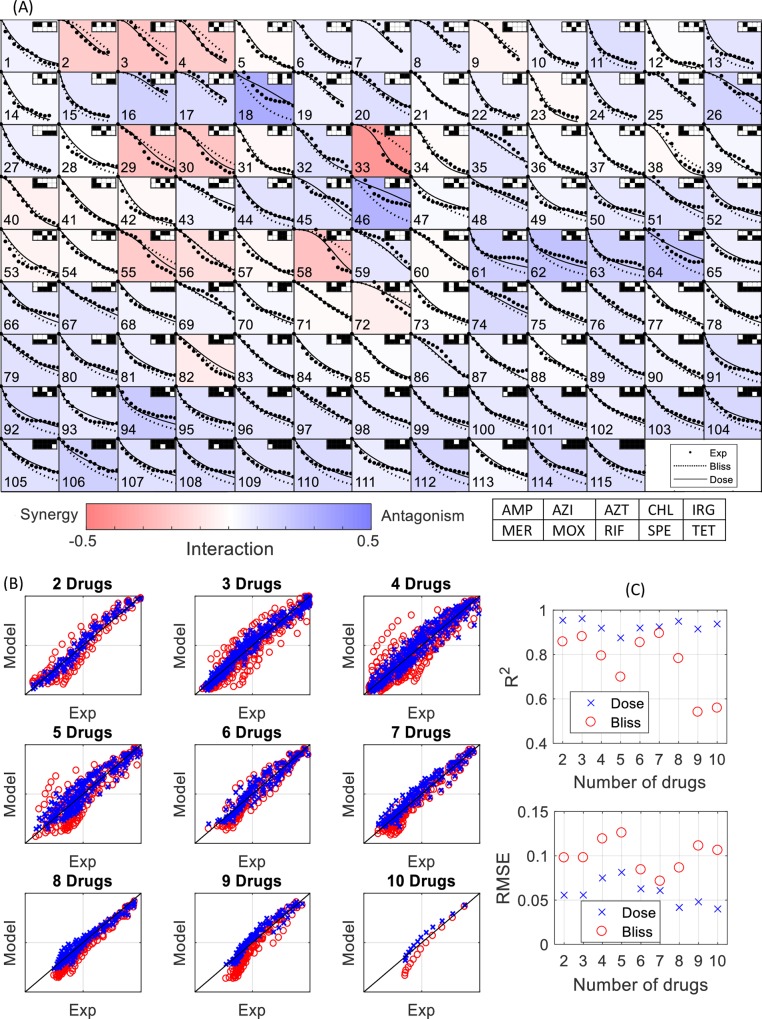
The dose model predicts well the effect of combinations of 2–10 antibiotics on E. coli growth.(A) The response curves for all 115 combinations (dots) compared to the dose model predictions (solid lines) and the bliss model predictions (dashed lines). The Interactions strength I = log(g12-g1g2+1), which indicates the mean deviation from the Bliss model (dashed line) is visualized by the color of each panel. The black and white squares on the top-right corner of each panel indicated which drugs where included in the cocktail. For example, in the first panel drugs AMP(1), MER(6) and MOX(7) were included in the cocktail. (B) The normalized growth compared to the dose model (x) and the Bliss model (o) predictions for 2–10 antibiotics. (B) R2 and RMSE values for the Dose model (x) and the Bliss model (o). The combination legend is also in S1 Table. The response curves presented here are the average of two (for combination 1–28) or three (for combination 29–115) biological replicates.